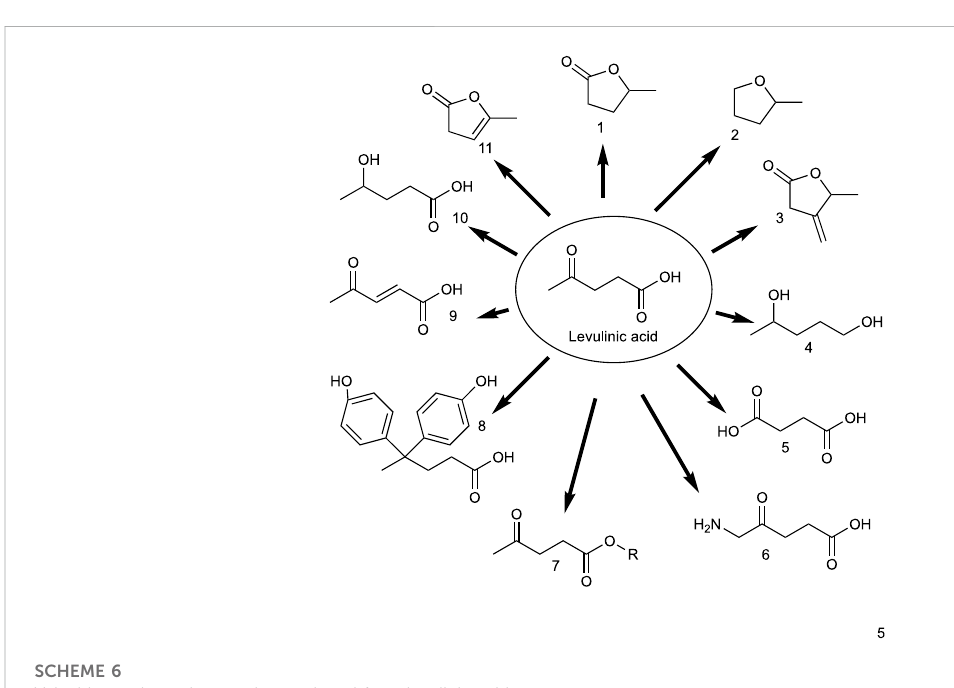
SCHEME 6 Valuable products that can be produced from levulinic acid.